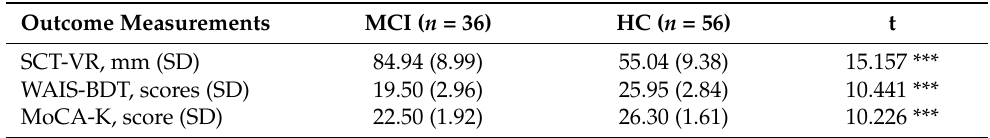
Table 2. Group differences in outcome measurements ( n = 92).